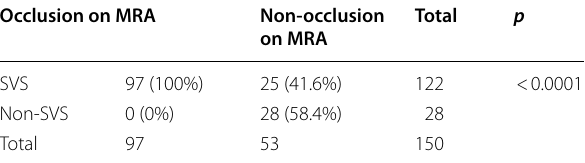
Table 2 SWI versus MRA in detection multiple intra-arterial